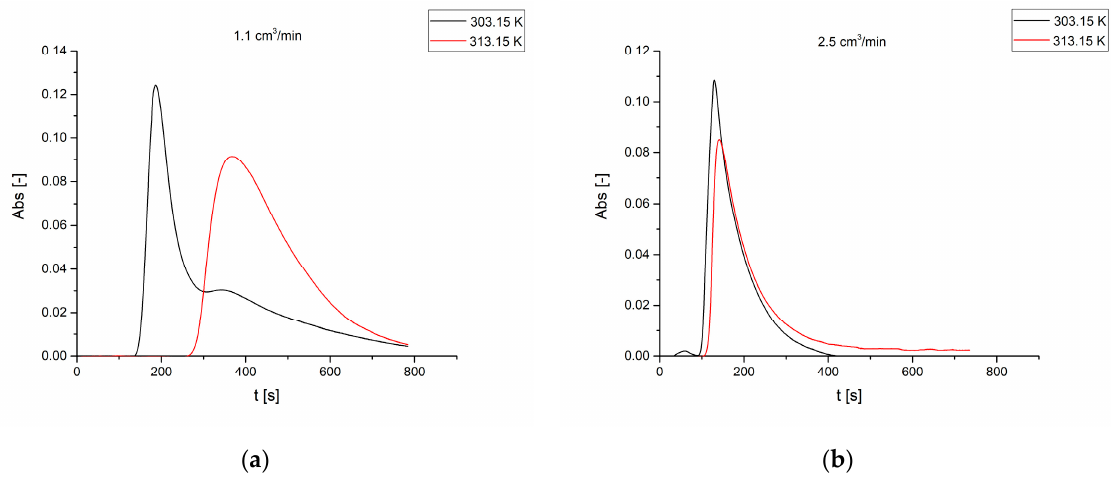
Figure 4. UV spectra for LA 6 M injections at 1.1 cm 3 /min ( a ) and 2.5 cm 3 /min ( b ) flow rate at different temperatures.